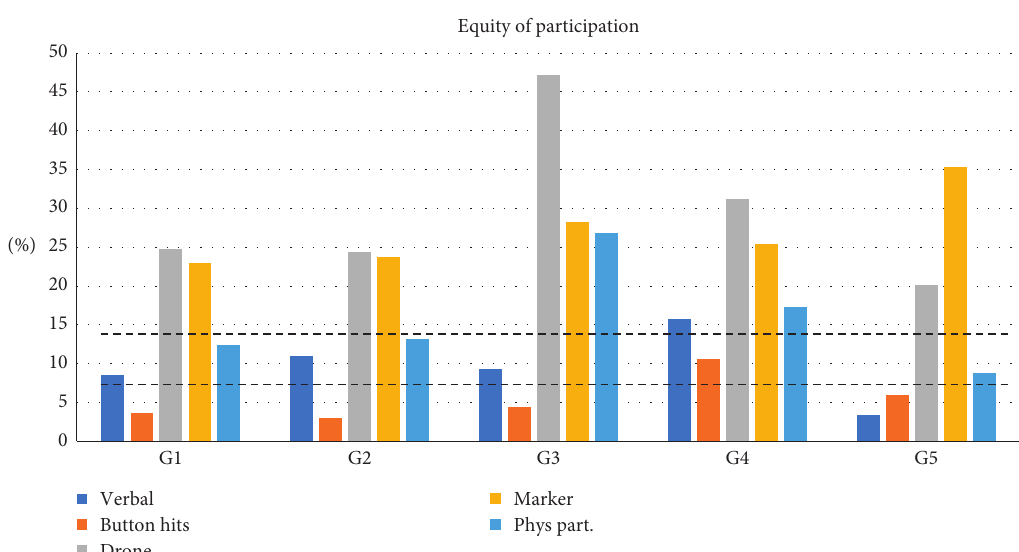
Figure 12: Equity of participation related to amount of speech, button hits, drone usage, and marker usage, with the latter three combined as physical